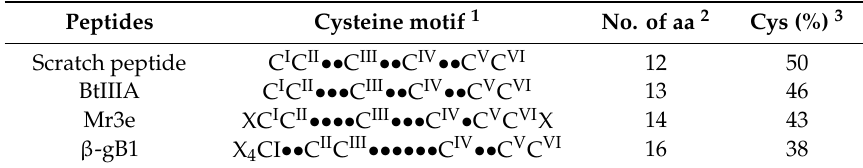
Table 1. Comparison of β -gB1 with three hyperdisulfide conotoxin